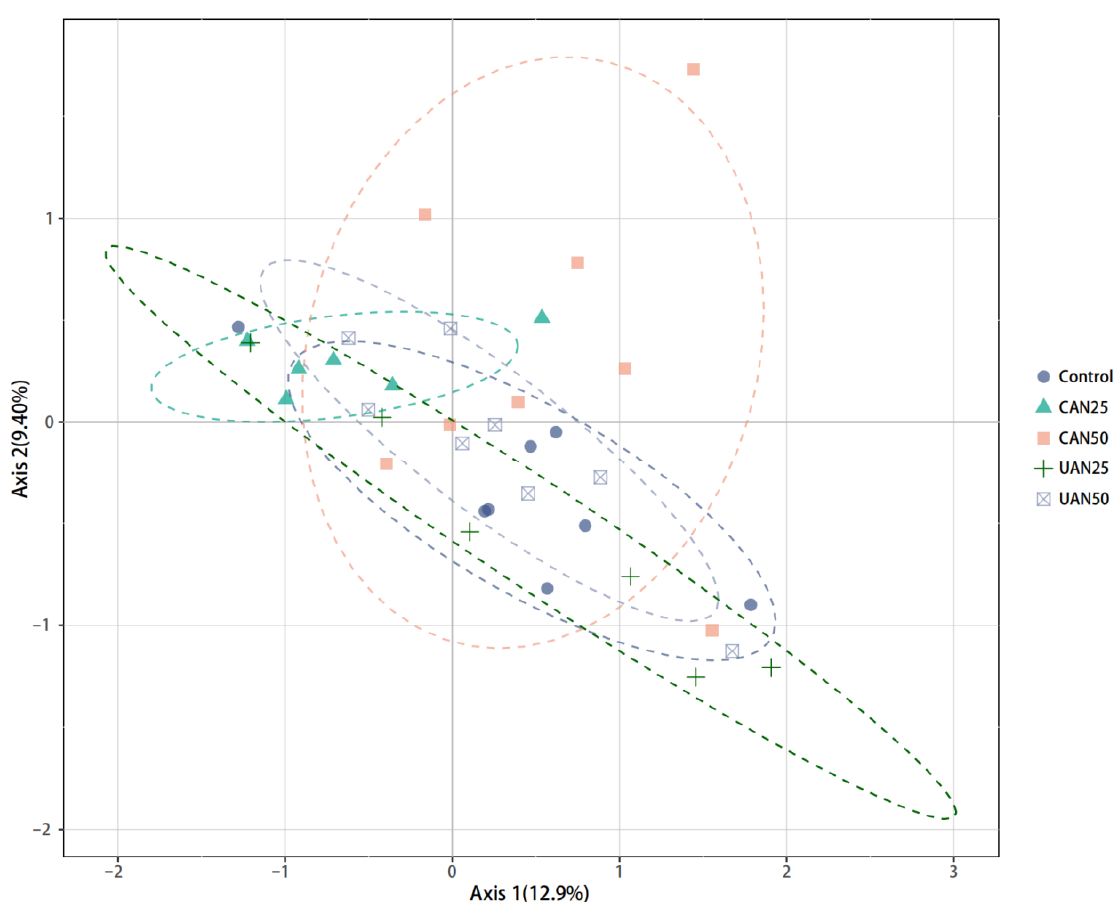
Figure 4. Detrended correspondence analysis (DCA) of soil seed bank composition under the five N-addition treatments (see Table 1 for details). Table 2. Soil chemical and microbial properties as affected by N-addition treatments across various canopy and under- story of the forest ecosystem.